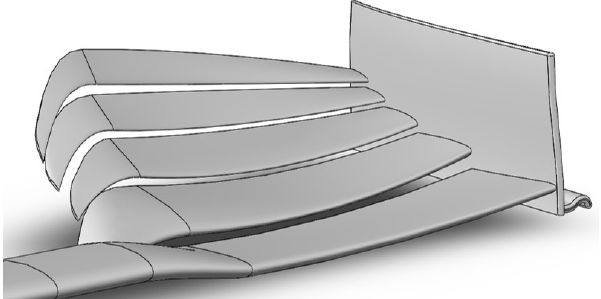
Figure 11. Final proposed 3D design by the hybrid optimisation